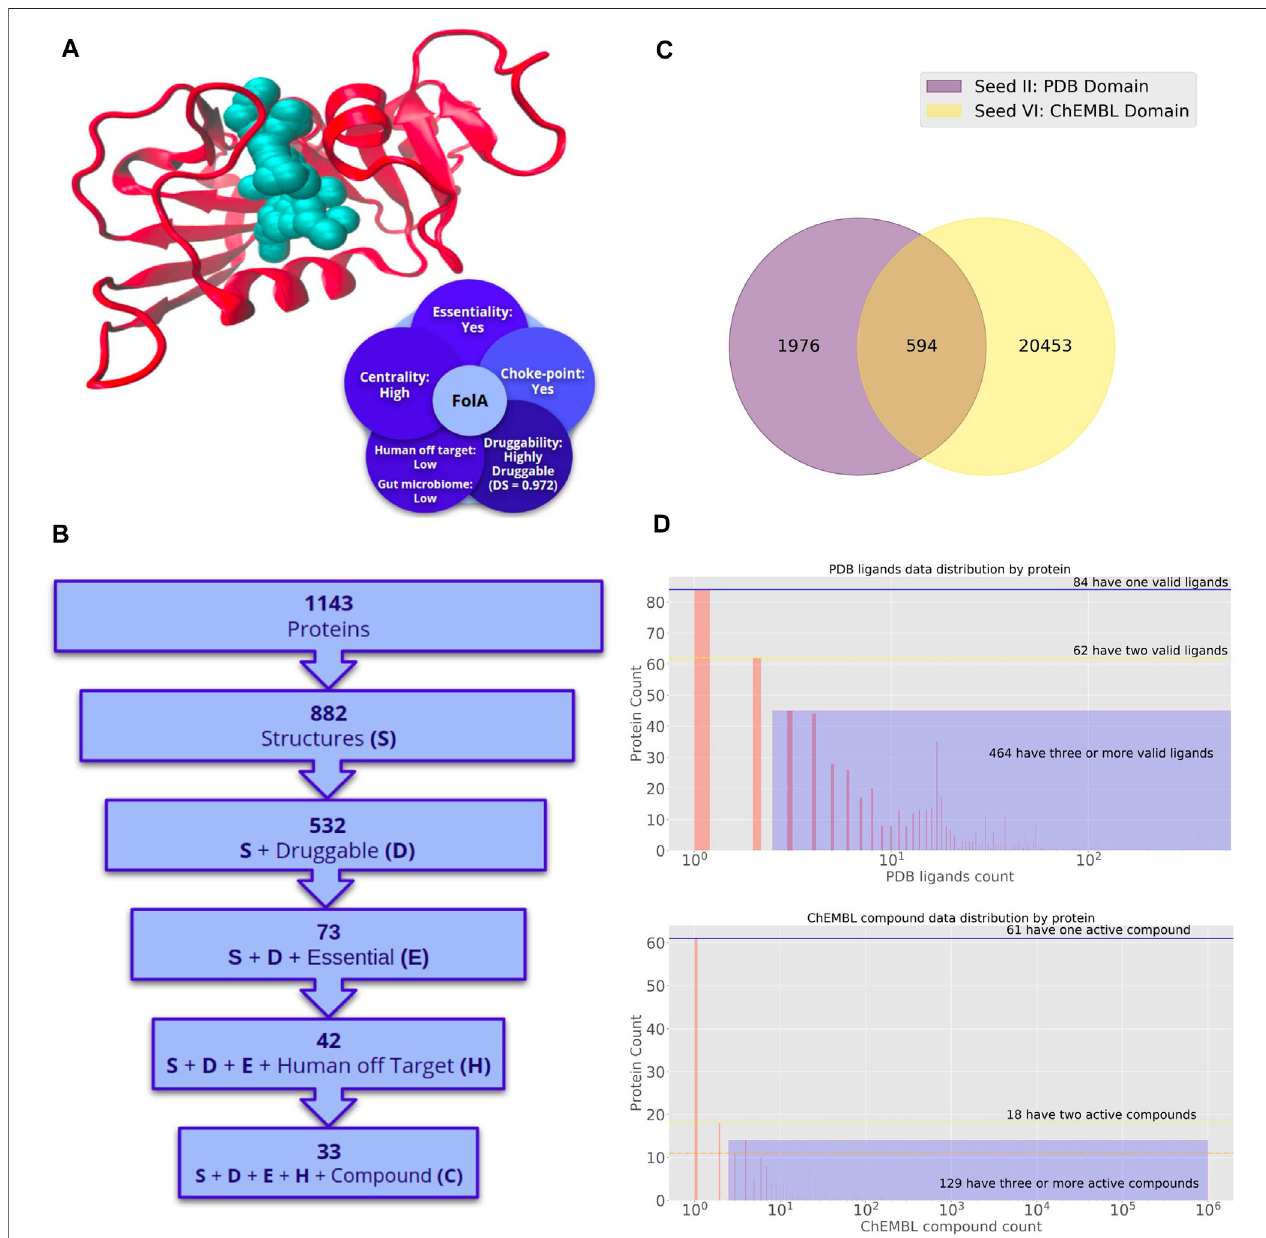
FIGURE 2 | Potential druggable targets and putative lead compounds to combat Bartonella bacilliformis . (A) Dihydrofolate reductase (FolA) structure. Crystallographic structure and a set of attractive features for target prioritization are shown. (B) Number of proteins in Bartonella bacilliformis genome with desirable propertiesfordrugtargets. Different fi ltersaresequentiallyapplied toobtainashortlistofdruggable,essential,andlowidentitieswithproteinsinthehumangenome.The last fi lter is applied to get the list of proteins with putative binders. (C) Seed Compounds for Bartonella bacilliformis . Venn diagram of the number of seed compounds corresponding to different sets. Binders are classi fi ed into two seed groups. Seed II are those drugs that bind any protein that harbor the same Pfam domains with Bb proteins and have been co-crystallized with such proteins in the PDB. Seed IV is the set of drugs that bind any protein that shares Pfam domains with Bartonellabacilliformis proteinsand wasreportedasactiveinChembl. (D) Numberofproteinsinthe Bartonellabacilliformis genomeforwhichaligandcanbepredicted. The top panel corresponds to drugs in Seed II. The bottom panel corresponds to drugs in Seed IV.